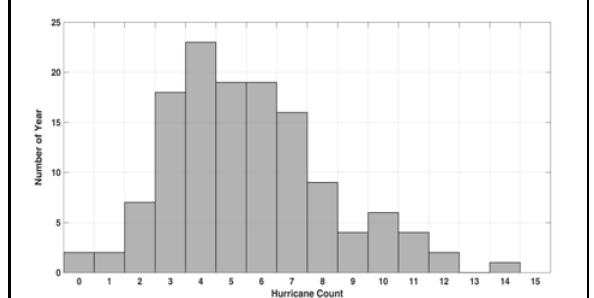
Figure 2. Distribution of yearly hurricane frequency in the ACR 1886 to 2017.